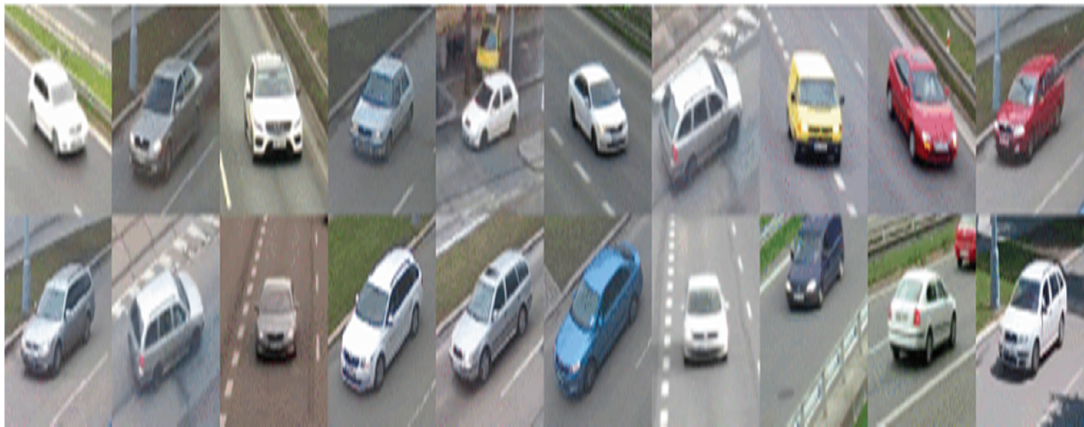
Figure 8. Depicts sample images of the BoxCar116k dataset.